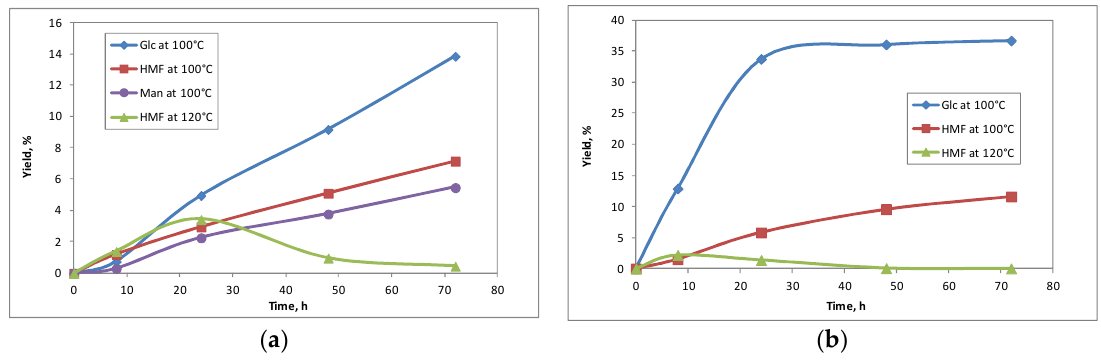
Figure 3. Conversion of cellulose to glucose, mannose and HMF in [BMIM]Cl at 100 and 120 °C by using POMs based on ( a ) molybdenum oxide and ( b ) tungsten oxide. Catalyst loading was 10 wt % from cellulose and cellulose loading was 10 wt % from solvent.